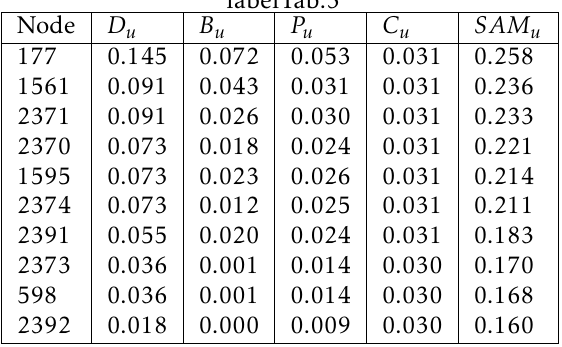
Table 4. Centrality Score of Top 10 Nodes, From Jakarta Dataset, Sorted by SAM